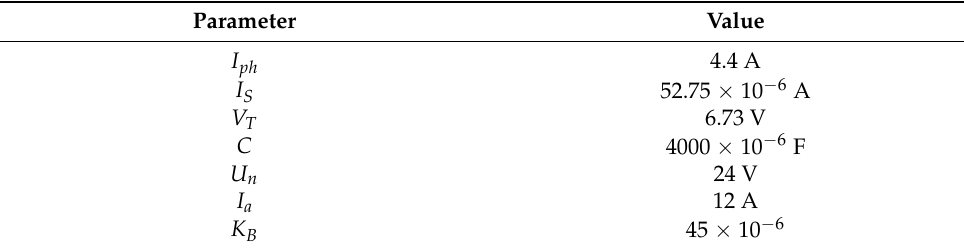
Table 2. Photovoltaic system parameters.